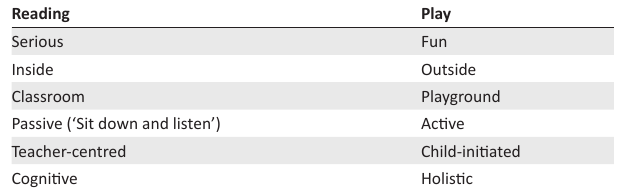
TABLE 2: The reading-play binary in